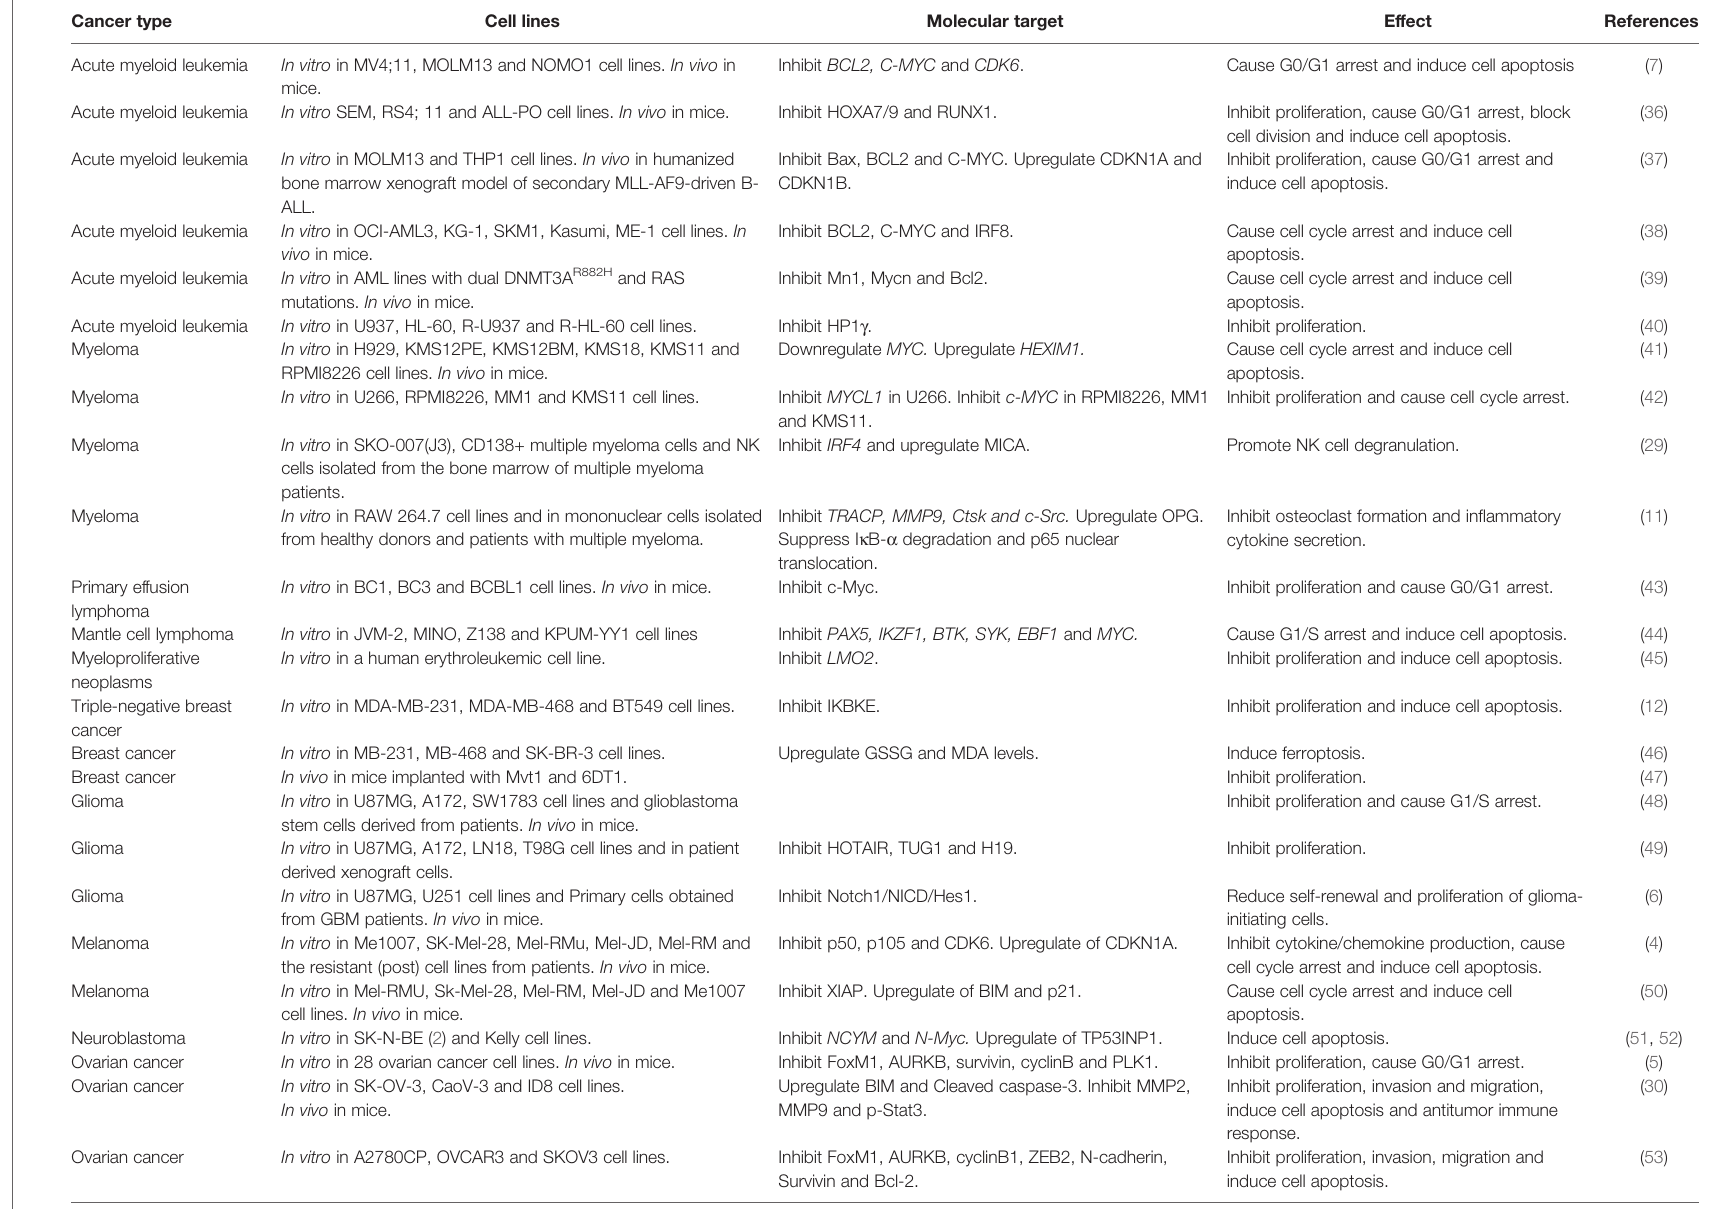
TABLE 1 | Anticancer activity of I-BET151 against various cancer cells. Cancer